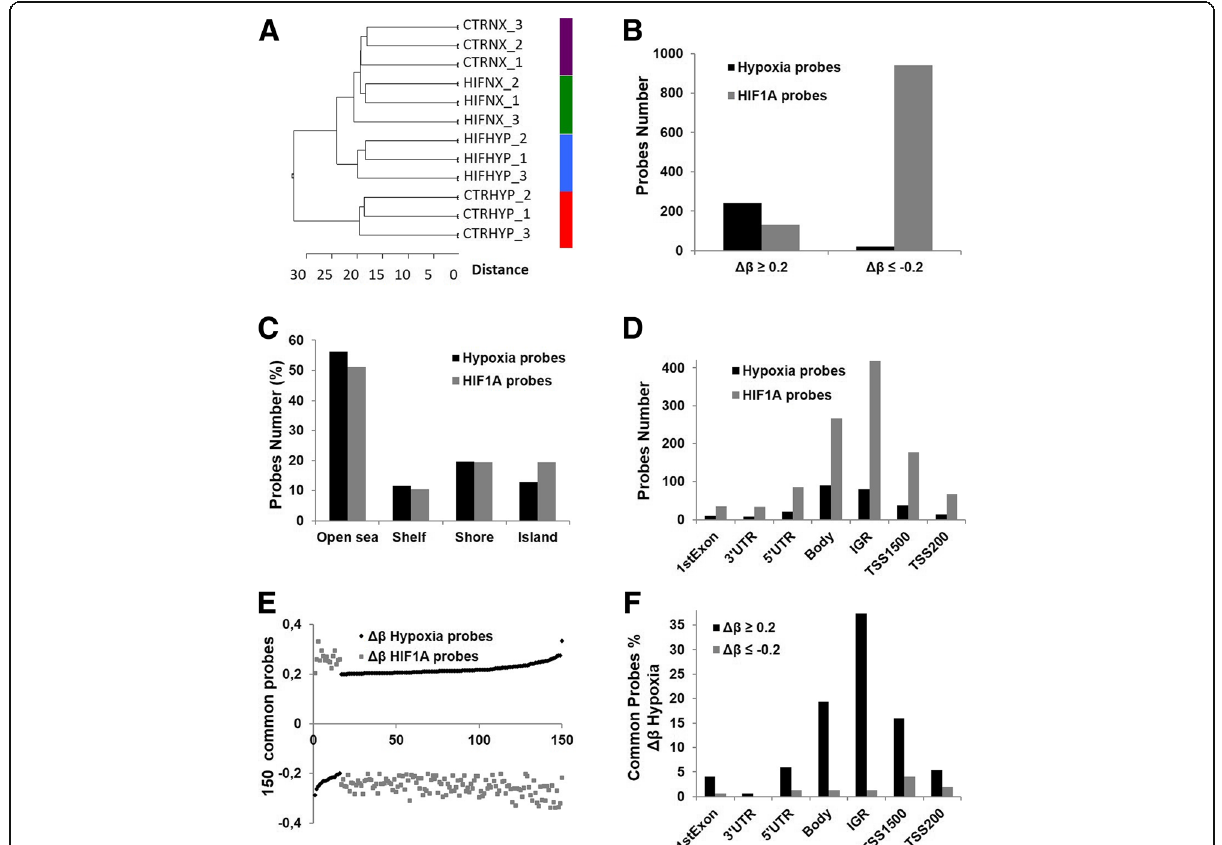
Fig. 3 DNA sites with variable methylation under hypoxia. a The top 1000 most variable CpG probes were used to perform hierarchical clustering based on Euclidean distances. The analysis well separated samples into four clusters grouping all the replicates of each experimental condition. b Overall distribution of hyper ( Δβ ≥ 0.2) and hypo-methylated ( Δβ ≤ − 0.2) probes of “ Hypoxia probes ” (shCTR HYP vs shCTR NX). and “ HIF1A probes ” (shHIF1A HYP vs shCTR HYP) c Distribution of “ Hypoxia probes ” and “ HIF1A probes ” in relation to CpG-centric annotation. d Distribution of “ Hypoxia probes ” and “ HIF1A probes ” to Gene-centric annotation. e Plot showing the inverse methylation status ( β values) of 150 probes (common probes) commonly methylated in “ Hypoxia probes ” and “ HIF1A probes ” . f Gene-centric distribution of hyper ( Δβ ≥ 0.2) and hypo- methylated ( Δβ ≤ − 0.2) common